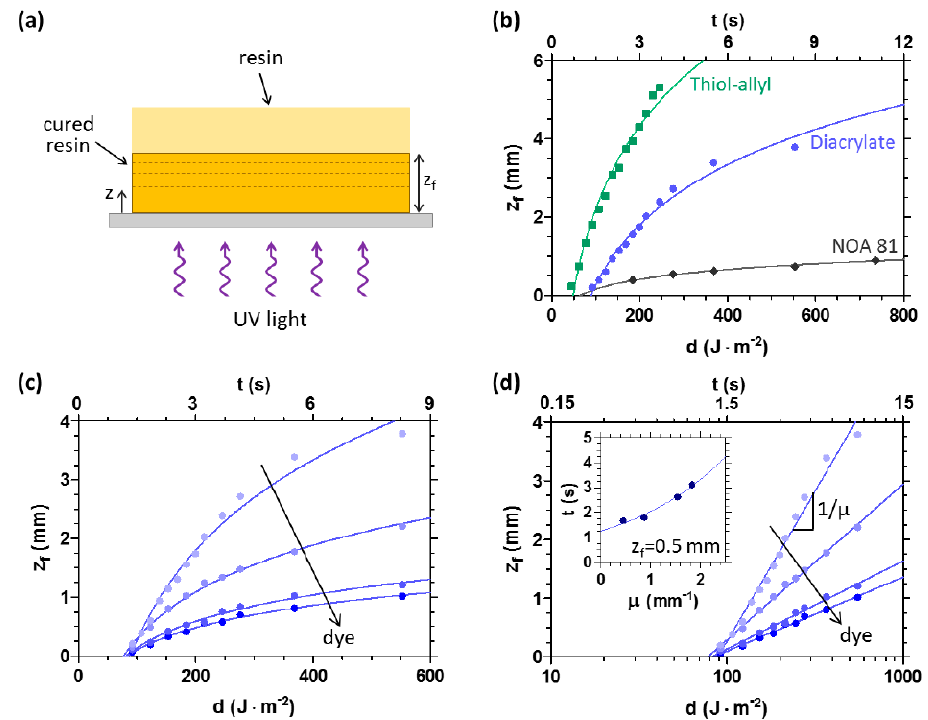
Figure 4. ( a ) Schematic of the FPP network formation in the ‘unbounded’ case (i.e., thick monomer layer), showing the front propagation from the UV illuminated surface. After a specific time (or dose) of UV exposure, the cured sample shows a well-defined thickness z f ; ( b ) sample thickness z f dependence on UV exposure dose d and time t , for acrylic and thiol-ene systems. A UV light intensity of 67 W·m − 2 was used; ( c , d ) effect of the introduction of a dye into the diacrylate system on the growth kinetics. The absorbing dye was added in the range 0–0.25 wt %, and the light intensity was 67 W·m − 2 . In ( d ), it is proven that the sample thickness z f increases logarithmically with d and t , after a critical value has been exceeded, showing a proportionality constant 1/ μ . In the inset, the exponential dependence of the exposure time t required to polymerise a 0.5 mm thick sample on the optical attenuation coefficient μ for diacrylate system is reported.